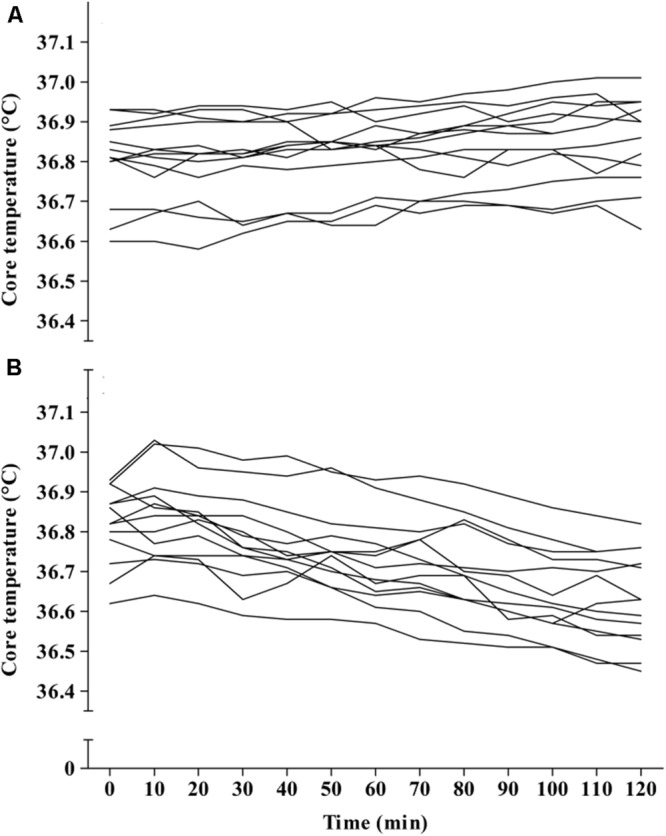
Individual core temperature (TC) responses in the placebo (A) and APAP condition (B).